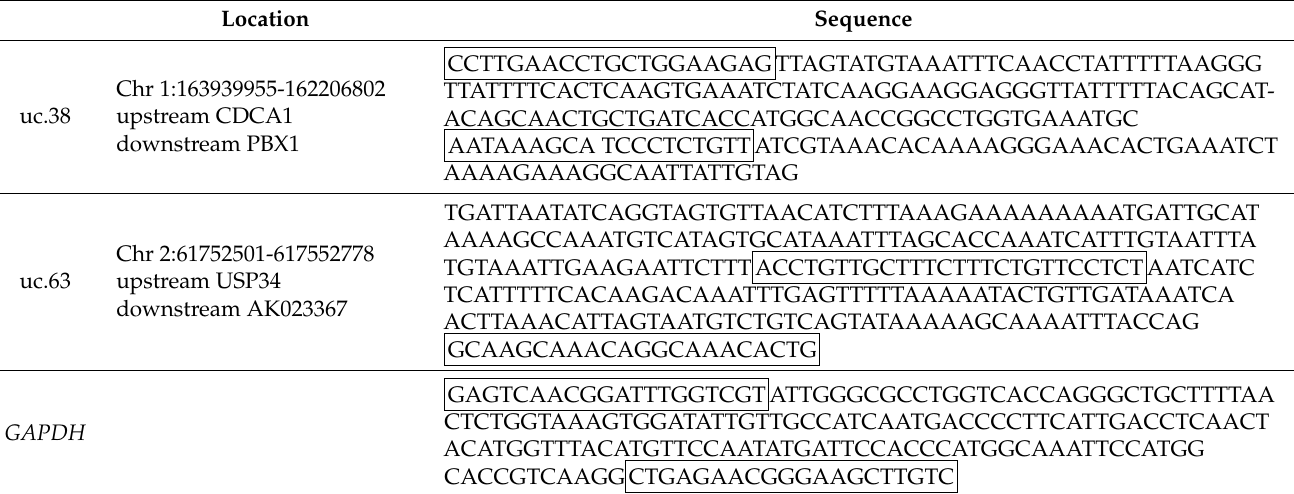
Table 4. Sequences of the amplified